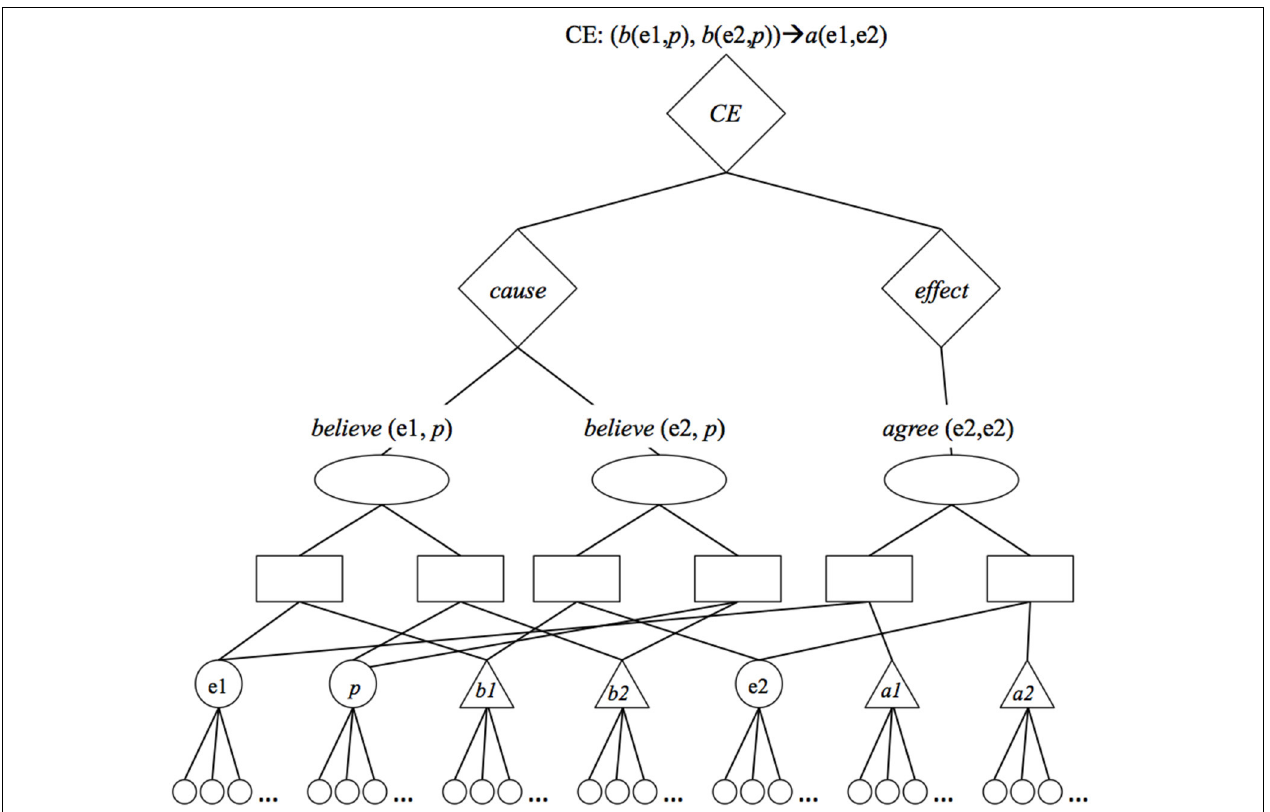
FIGURE 2 | LISA representation of the cause-effect relation: Entity 1 believes proposition p [believe (e1, p)] , entity 2 believes proposition p [believe (e2, p)] , and these facts jointly cause e1 to agree with e2 [ agree (e1, e2)]. To represent that believe (e1, p ) and believe (e2, p ) jointly cause something, the units representing these propositions (left-most ovals) share bi-directional excitatory connections to a unit (left-most diamond) representing a cause group. To represent that agree (e1, e2) is the effect of something, the